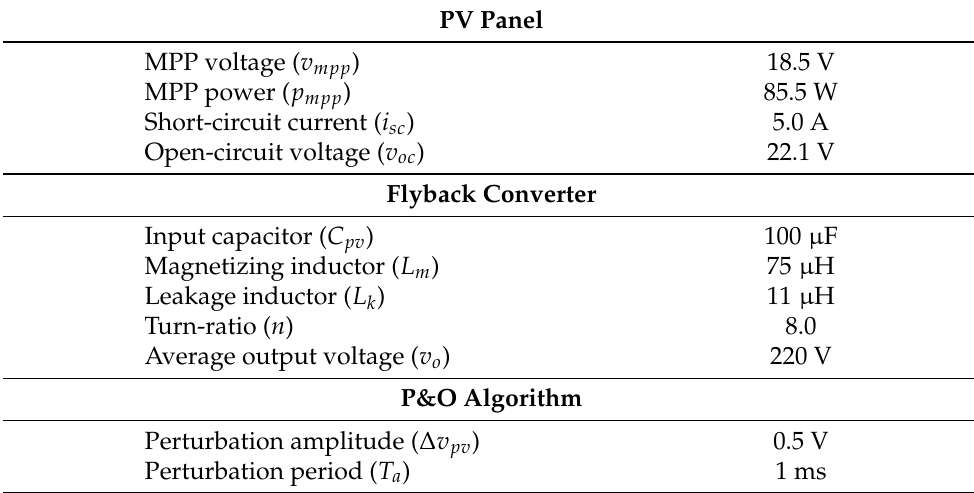
Table 1. Parameters for the design